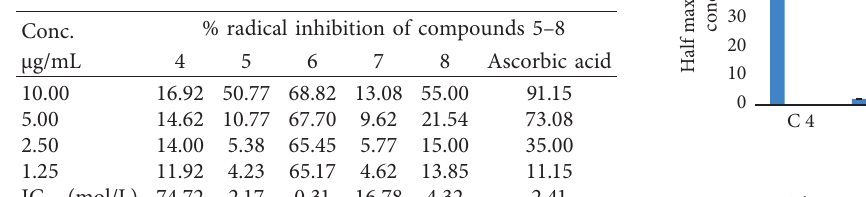
Figure 3: The IC50 values of the synthesized